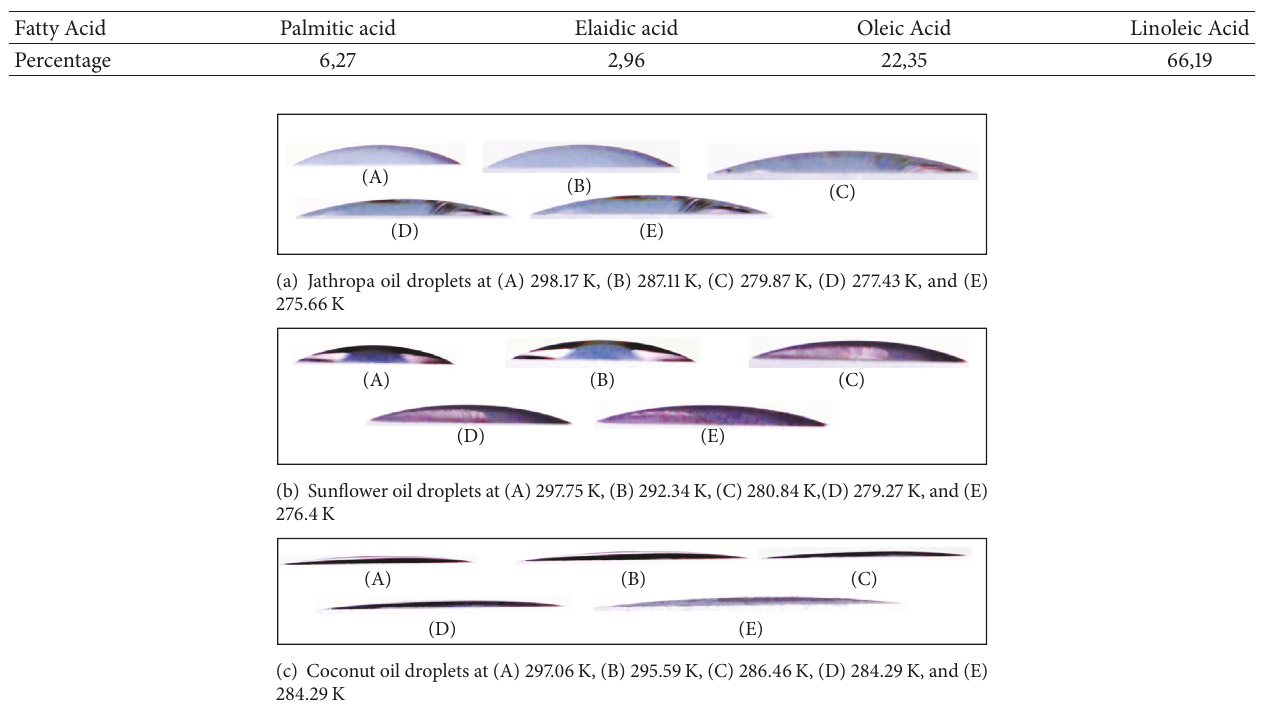
Table 3: Fatty acid composition of sunflower oil.